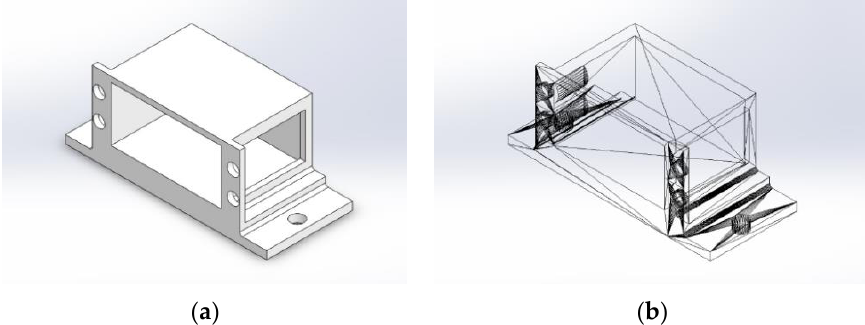
Figure 6. Servo motor housing: ( a ) Visualization in SolidWorks; ( b ) SolidWorks mesh model.